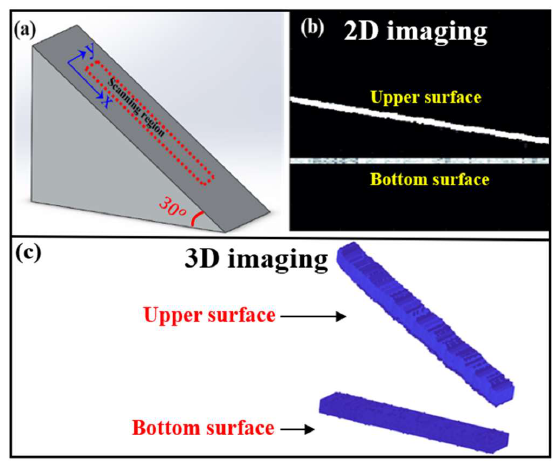
Figure 9. ( a ) Physical model, ( b ) lateral 2D image of the physical model and ( c ) 3D image of a certain region of the physical model.